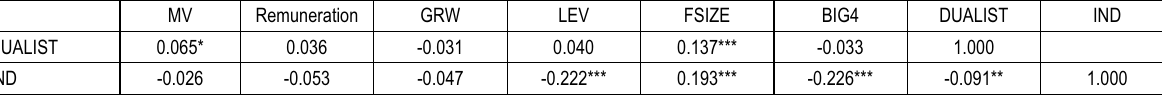
Table 5 (cont.). Multicollinearity for ROA and Market Value (MV)